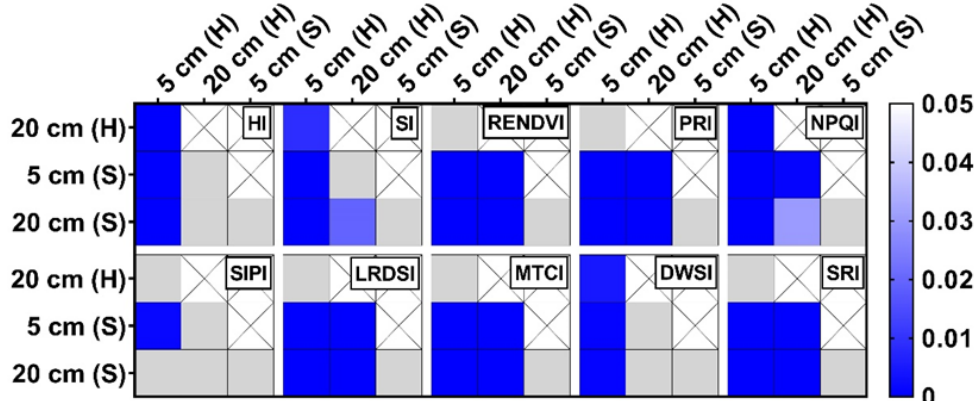
Figure 9. Heat map of p values for different indices calculated based on Dataset (B). H, M and S in x and y axis denote healthy, moderate and severe, respectively. Cross means no data, and gray box means not significant.